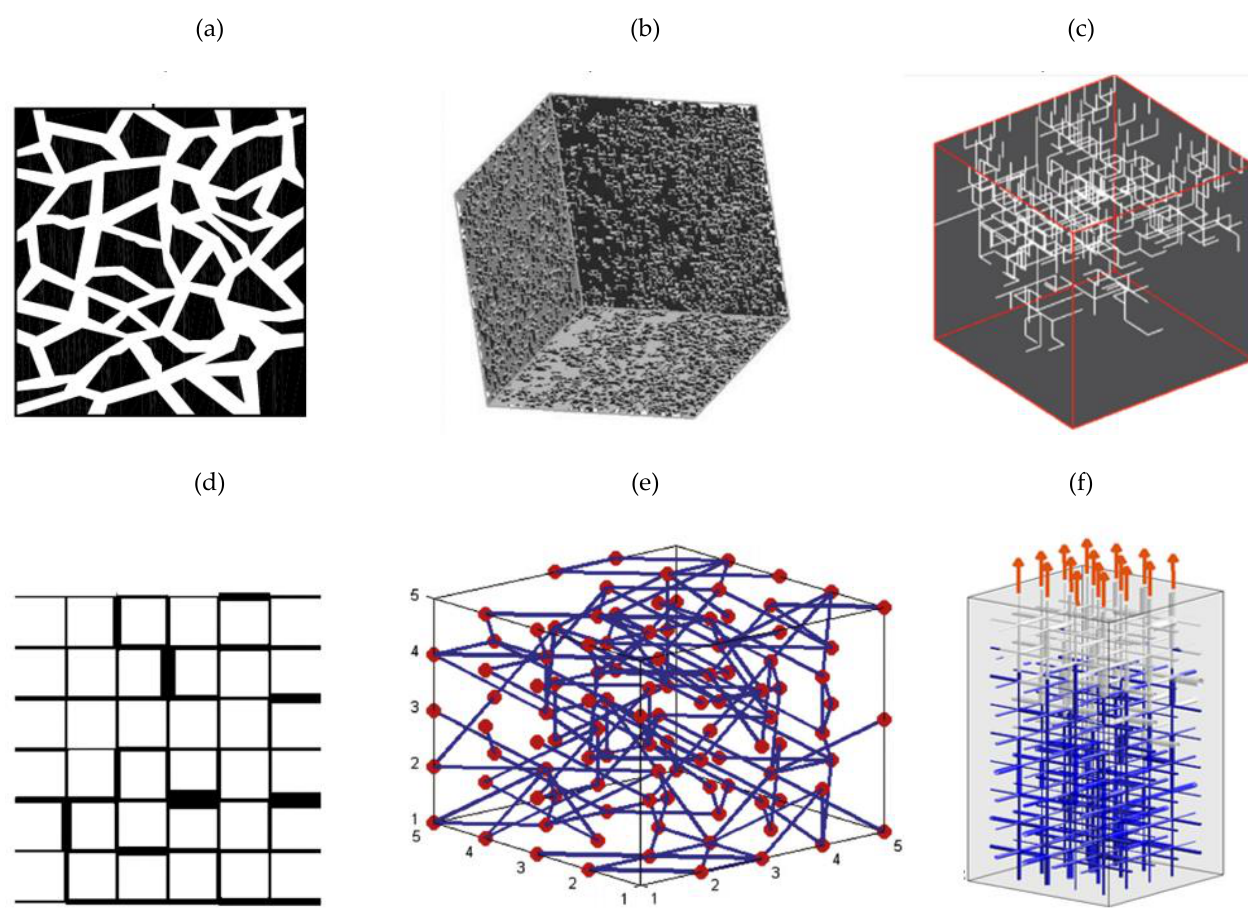
Figure 2. Network models: ( a )–[4]; ( b )–[5]; ( c )–[6]; ( d )–[7]; ( e )–[8]; ( f )–[9].